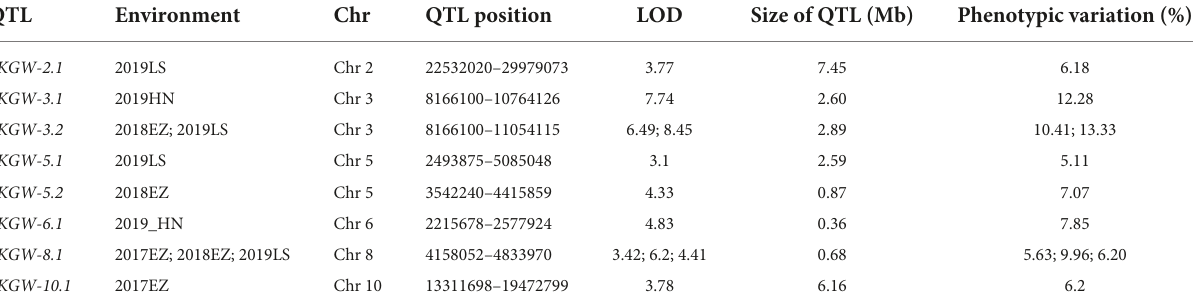
TABLE 2 Details of thousand-grain weight